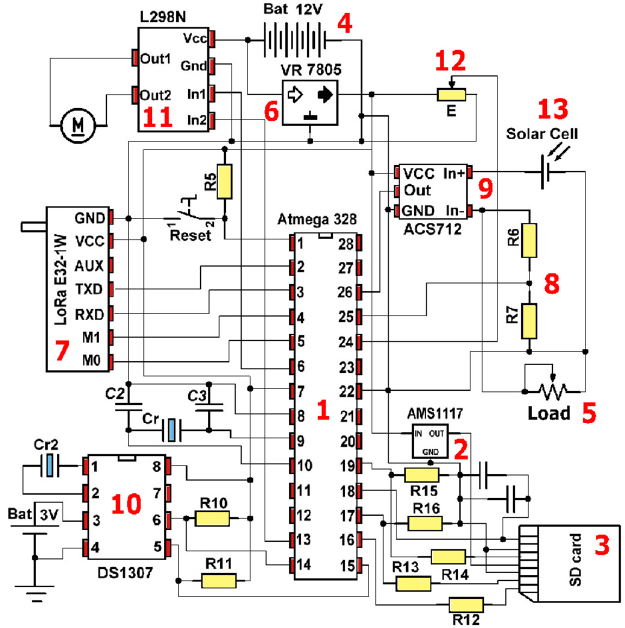
Figure 5. Functional diagram of the electronic control unit of a single-axis Solar tracking system based on astronomical calculations.